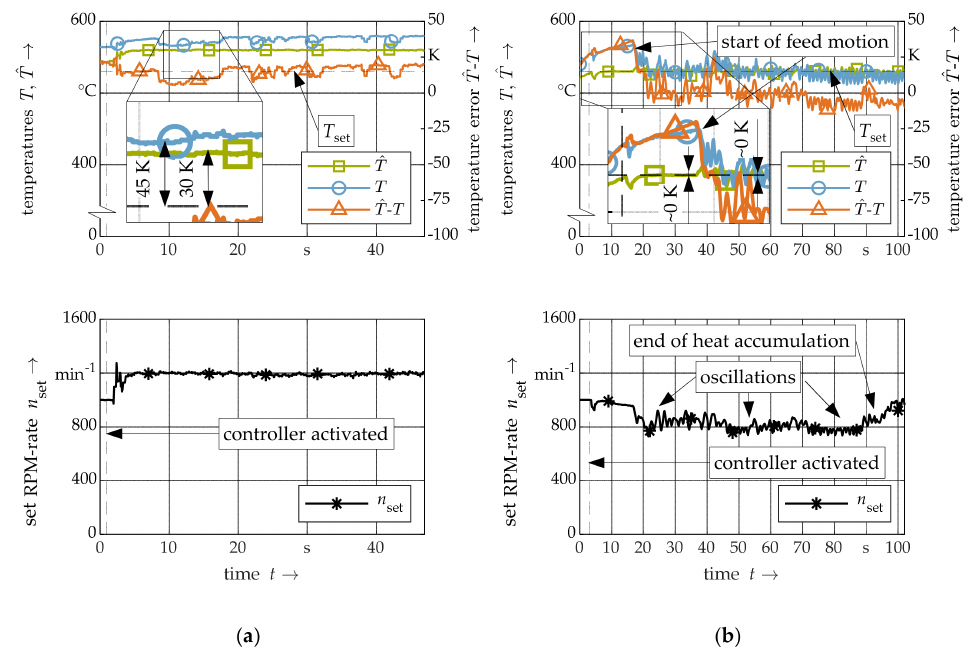
Figure 6. Validation of the complete control structure: comparison of the measured temperature T (blue circle) to the calculated temperature ˆ T (green square) as well as the temperature model error ˆ T - T (orange triangle) and the set RPM-rate n set (black asterisk) for a lap weld with the application of the correction o ff set T corr i.e. experiment no. 13 ( a ) and a bead-on-plate weld without a correction o ff set T corr , i.e. experiment no. 14 ( b ); the corresponding welding parameters are given in Table 2.